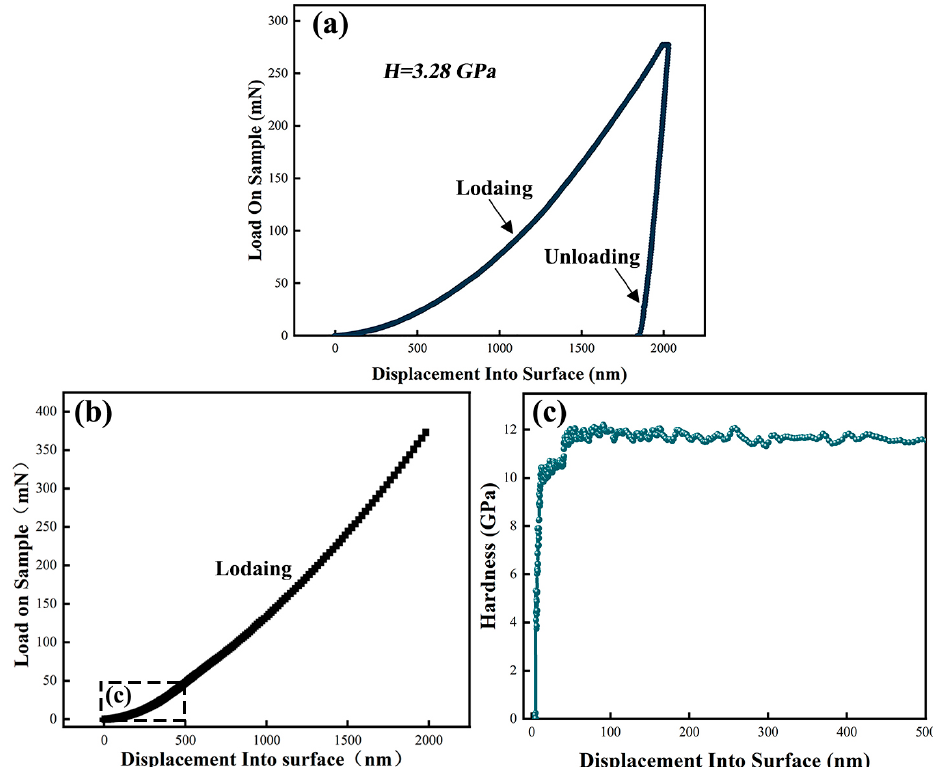
Figure 5. ( a ) Typical load − displacement curve of the T91 steel substrate; ( b ) load − displacement curve of the coating; ( c ) hardness − displacement curve of the as deposited AlTiCrFeMoSi HEA